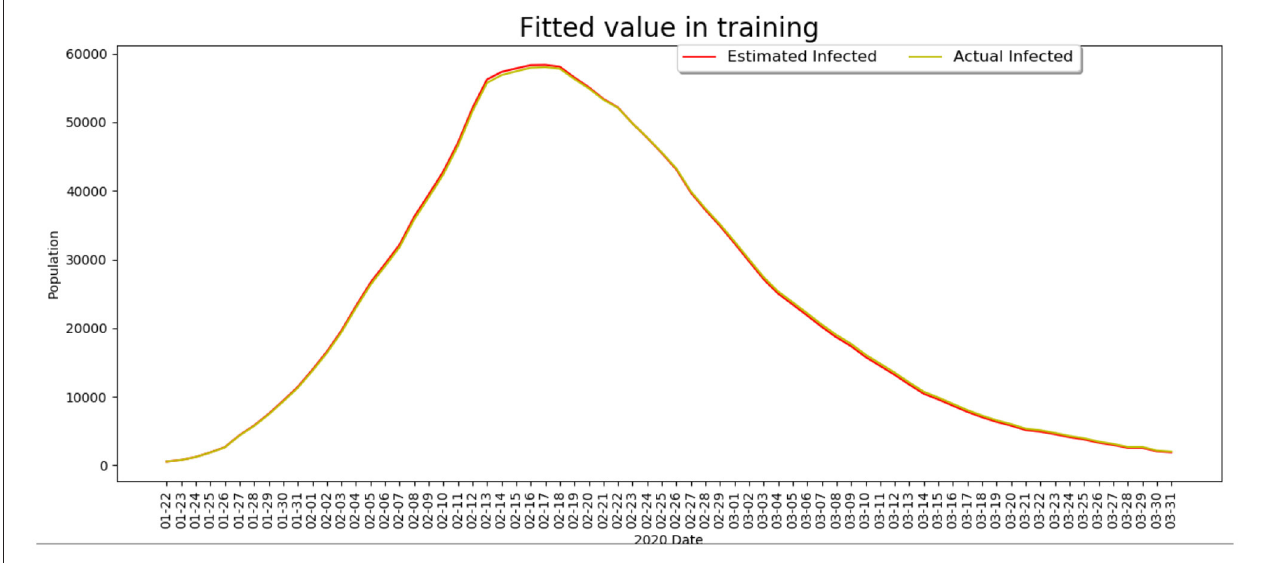
FIGURE 2 | The comparison of the infected cases between the model estimate and the real data.